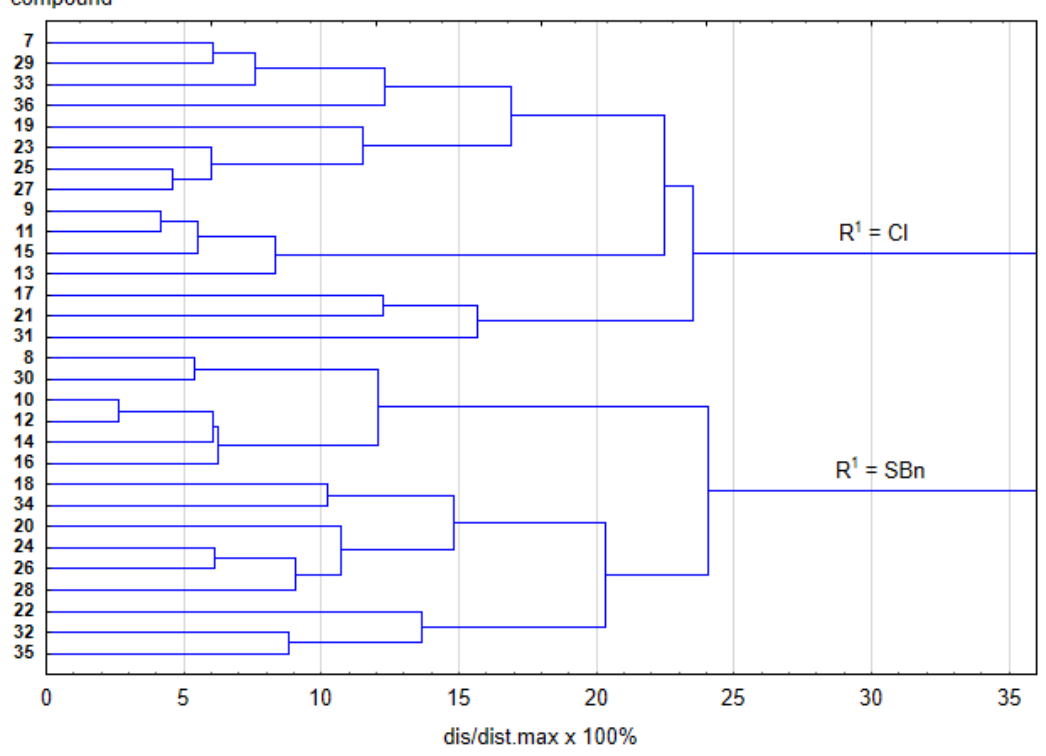
Figure 4. Dendrogram of hierarchical cluster analysis performed with Ward’s method for compounds 7 - 36 in view of their molecular descriptors. 7 – 36 in view of their molecular